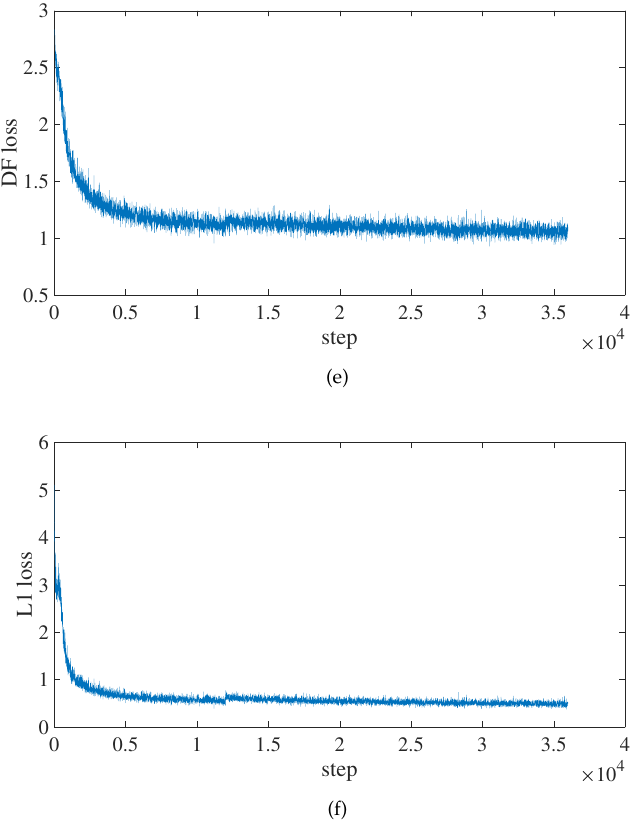
Figure 10. AP and loss values change of the improved PP-YOLOE-m network during training. ( a ) The change curve of the AP value. ( b ) The change curve of the toatl loss value. ( c ) The change curve of the classification loss value. ( d ) The change curve of the regression loss value. ( e ) The change curve of the DF loss value. ( f ) The change curve of the L1 loss value.